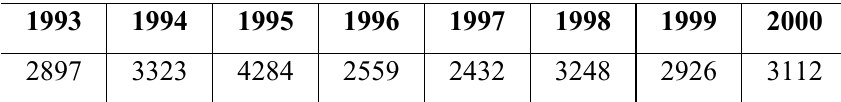
Table1. Number of Tityus serrulatus received by the